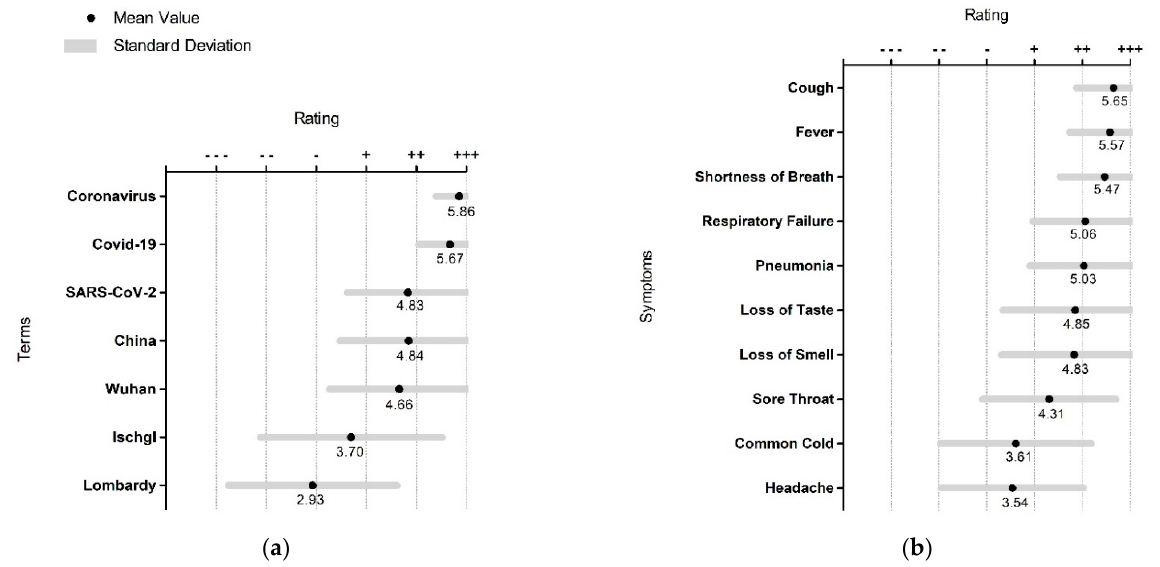
Figure 2. ( a ) Level of familiarity with synonyms and terms related to the coronavirus; ( b ) level of familiarity with COVID-19 symptoms; (ranging from ( −−− ) for completely unknown to (+++) for very well-known).